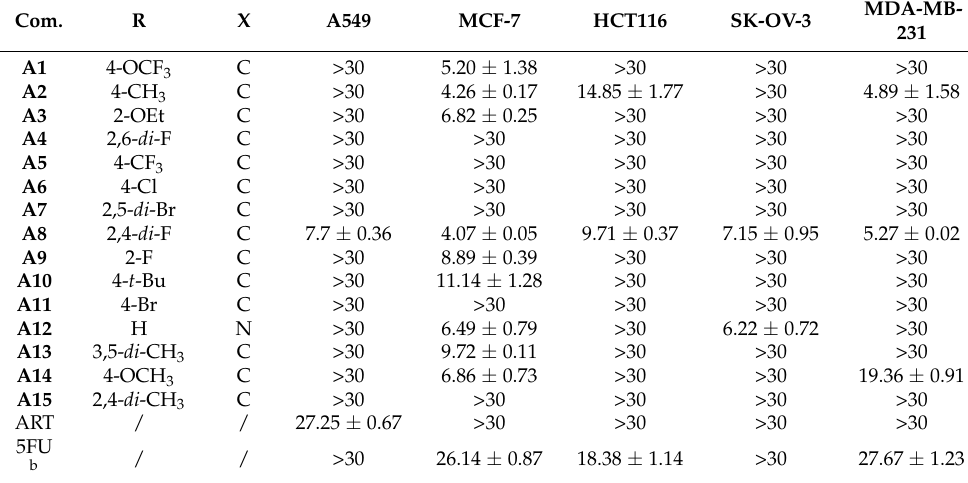
Table 1. IC 50 values a ( µ M) of hybrid A1 – A15 , ART and 5-FU against five human cancer cell lines. Com.